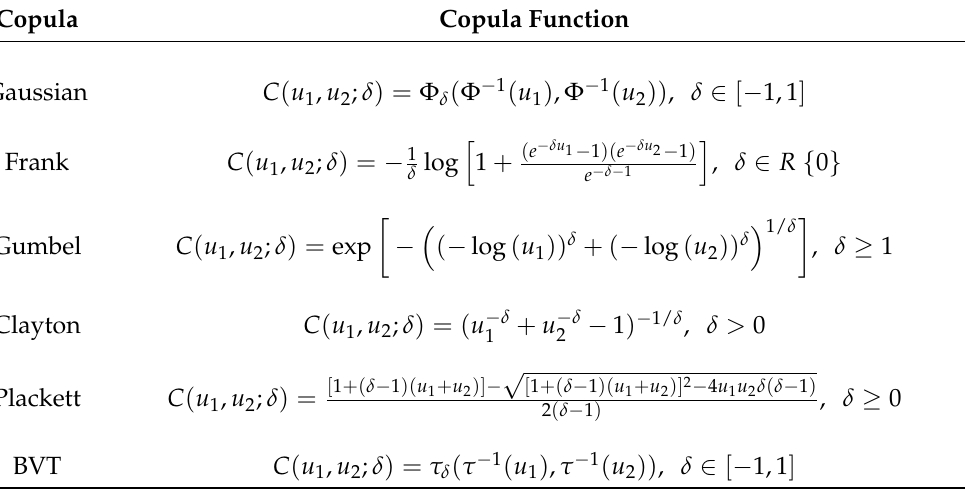
Table 1. Bivariate copula